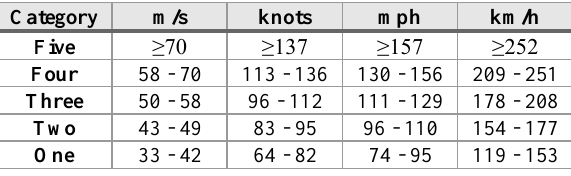
Table 1. Saffir-Simpson hurricane wind scale